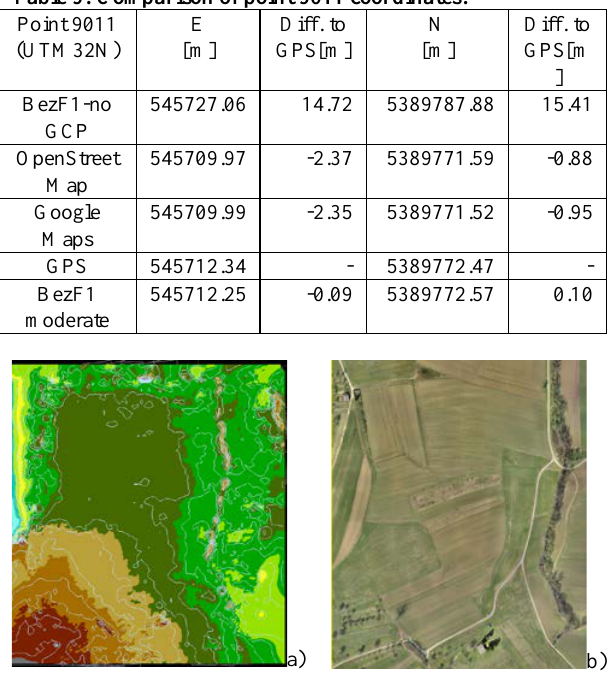
Figure 9: BezF1 with moderate # of GCPs. a) DSM BezF1, b) Orthomosaik